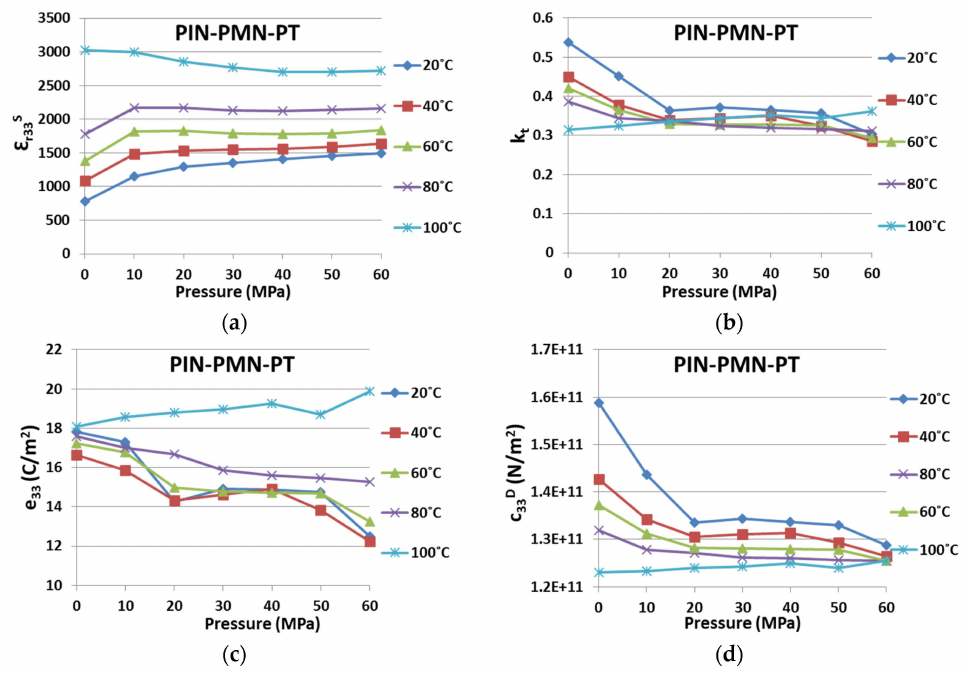
Figure 6. Property variation caused by environmental temperature and uniaxial pressure for PIN-PMN-PT on ( a ) ε r 33 S ; ( b ) k t ; ( c ) e 33 ; and ( d ) c 33 D .